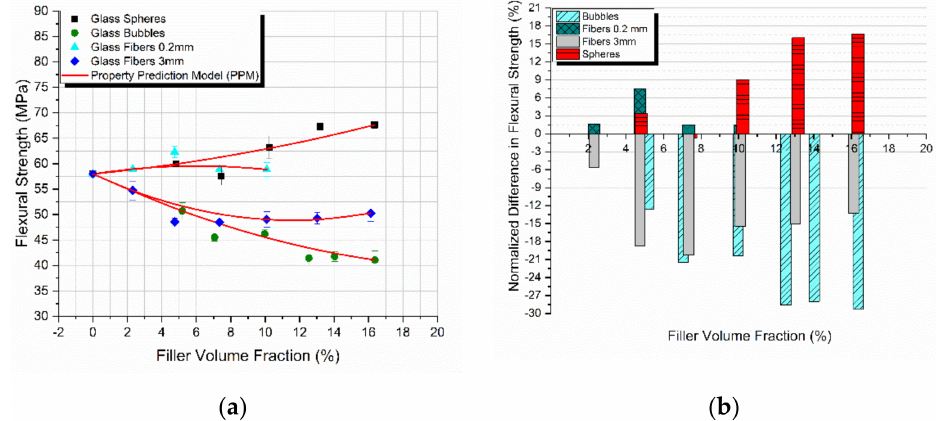
Figure 8. Comparison for all types of composites studied ( a ) between the experimental values and theoretical predictions as derived from the PPM model for the flexural strength with the filler-volume fraction, and ( b ) normalized strength variation with V f relative to the